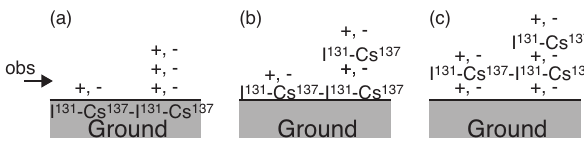
Fig. 4. Illustration of the possible contamination forms of the ra- dioactive materials near the ground: (a) migrating subsurface soil, (b) attaching at the top layer of the soil, (c) suspended in the air near the ground. In each panel, the left-hand side shows the distribution without wind or heat-induced convection and the right hand side shows the distribution when the heat-induced convection or wind lifts particles/ions up from the surface. Subsurface contamination here means that a substantial part of the radiation is absorbed by the soil before it reaches the air. The ionized soil particles at the surface by this absorption might be lifted up by the